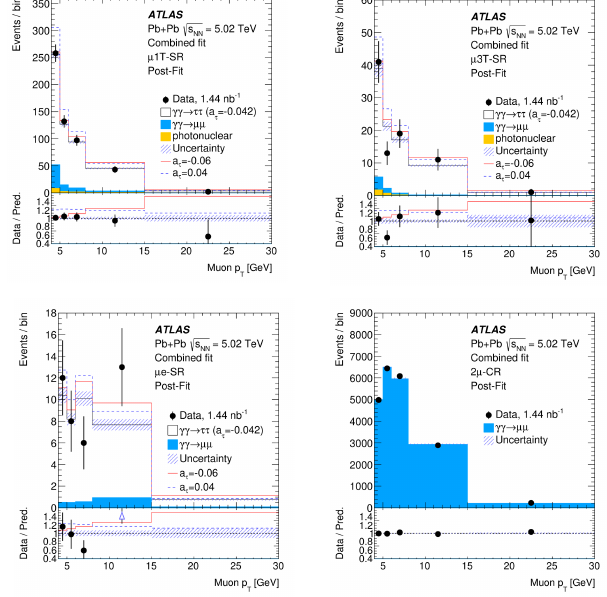
Figure 9. Muon p T -distribution in µ 1T-SR (top-left). Muon p T -distribution in µ 3T-SR (top-right). Muon p T -distribution in µ e-SR (bottom-left). Muon p T -distribution in 2 µ -CR (bottom-right). Black markers denote data and stacked histograms indicate the di ff erent components contributing to the re- gions. Post-fit distributions are shown with the signal contribution corresponding to the best-fit a τ value ( a τ = 0.041). For comparison, signal contributions with alternative a τ values are shown as solid red ( a τ = 006) or dashed blue ( a = 0.04) lines. The bottom panel shows the ratio of the data to post-fit predic- τ tions. Vertical bars denote uncertainties from the finite number of data events. Hatched bands represent ± 1 σ systematic uncertainties of the prediction with the constraints from the fit applied